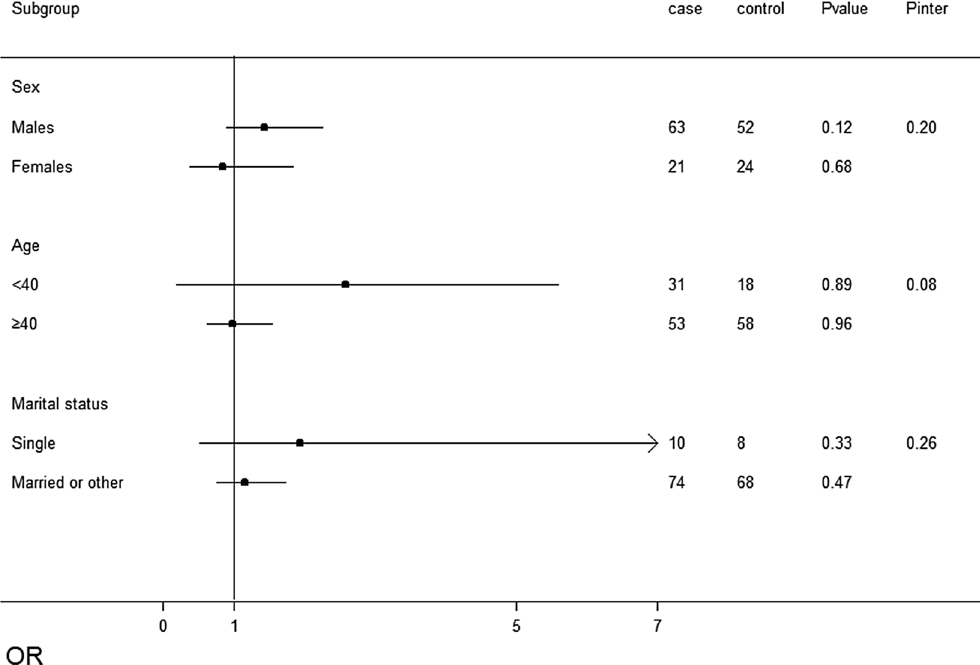
Figure 4. Association tests of copy number variation (CNVs) gains in patients with non-alcoholic fatty liver disease (NAFLD) across strata for various factors. The Forest plot represents the odds ratios (ORs) of the comparison of carboxylesterase 1 ( CES1 ) CNVs gains versus the neutral CNVs, adjusting for age, sex, education level, occupational status, income, marital status, smoking status, tea drinking status, exercise, history of diabetes, hyperlipidaemia, and hypertension. P inter indicates the P value for the interaction between the strata and CNVs gains.